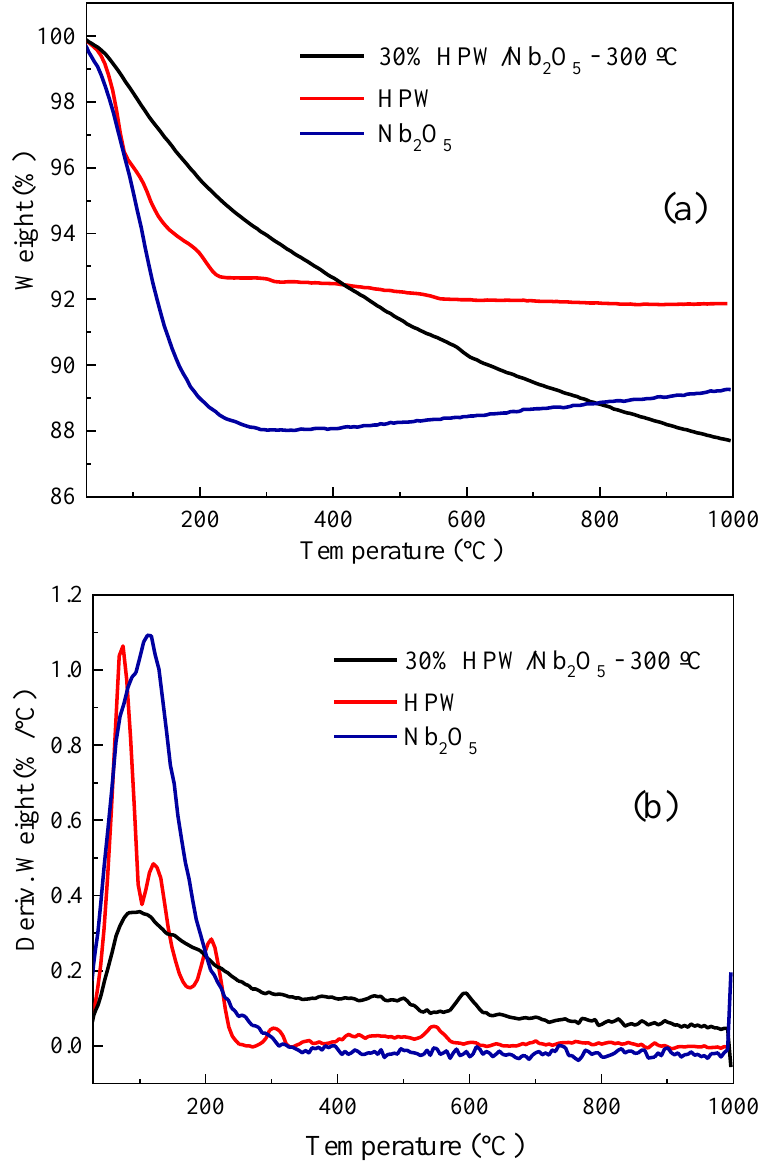
Figure 3. ( a ) Thermogravimetric analysis — thermogravimetric analysis (TGA) and ( b ) derivative thermogravimetry (DTG) of the HPW active phase, Nb 2 O 5 support, and HPW / Nb 2 O 5 catalyst calcined at 300 °C.